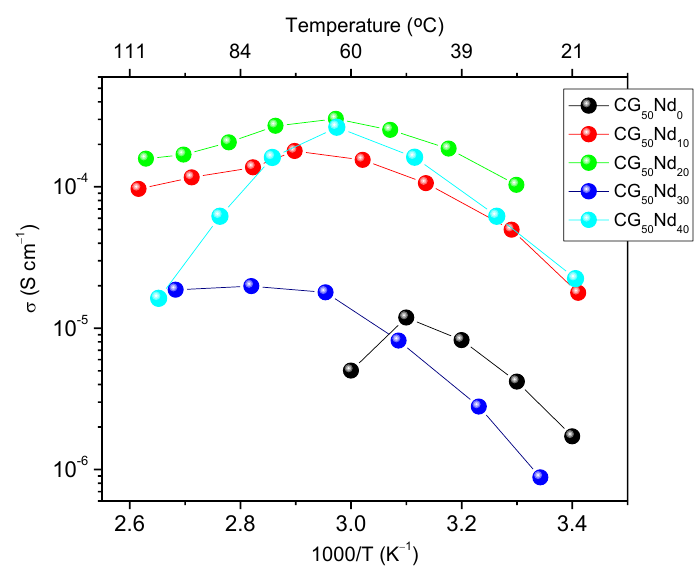
Figure 5. Arrhenius conductivity plot of the CG 50 Nd z membranes.